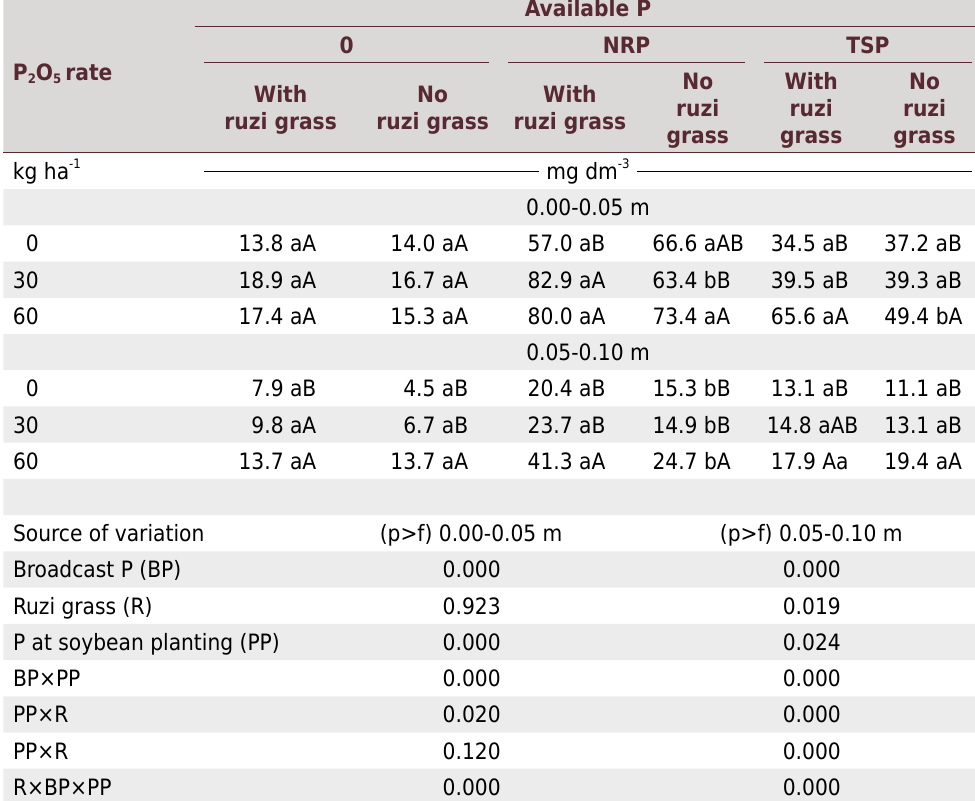
Table 2. Available P (resin) at soybean planting and P values (p>f) at soil depths of 0.00-0.05 and 0.05-0.10 m, as affected by phosphates (soluble and reactive) broadcast in the presence or absence of ruzi grass and P rates applied to soybean seed furrows (0, 30, and 60 kg ha -1 of P 2 O 5 as TSP). November